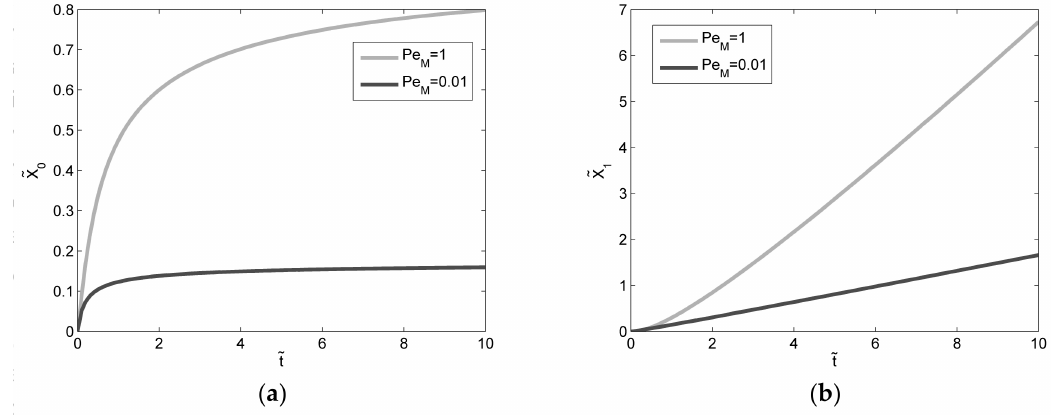
Figure 3. ( a ) Function (cid:102) X 0 for two different macro-Peclet numbers at (cid:101) x ∗ = 1; ( b ) Function (cid:102) X 1 for two different macro-Peclet numbers at (cid:101) x ∗ =